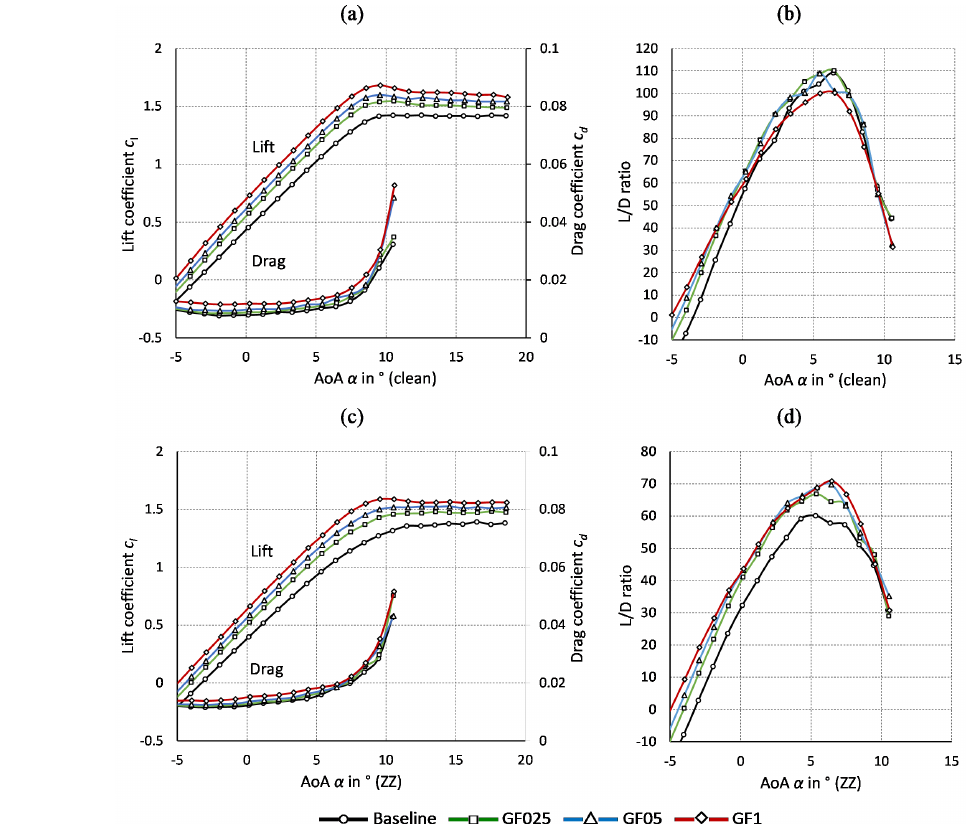
Figure 8. NACA63(3)618. Gurney flaps. (a) Lift and drag coefficients (clean). (b) L/D ratio (clean). (c) Lift and drag coefficients (ZZ). (d) L/D ratio (ZZ).